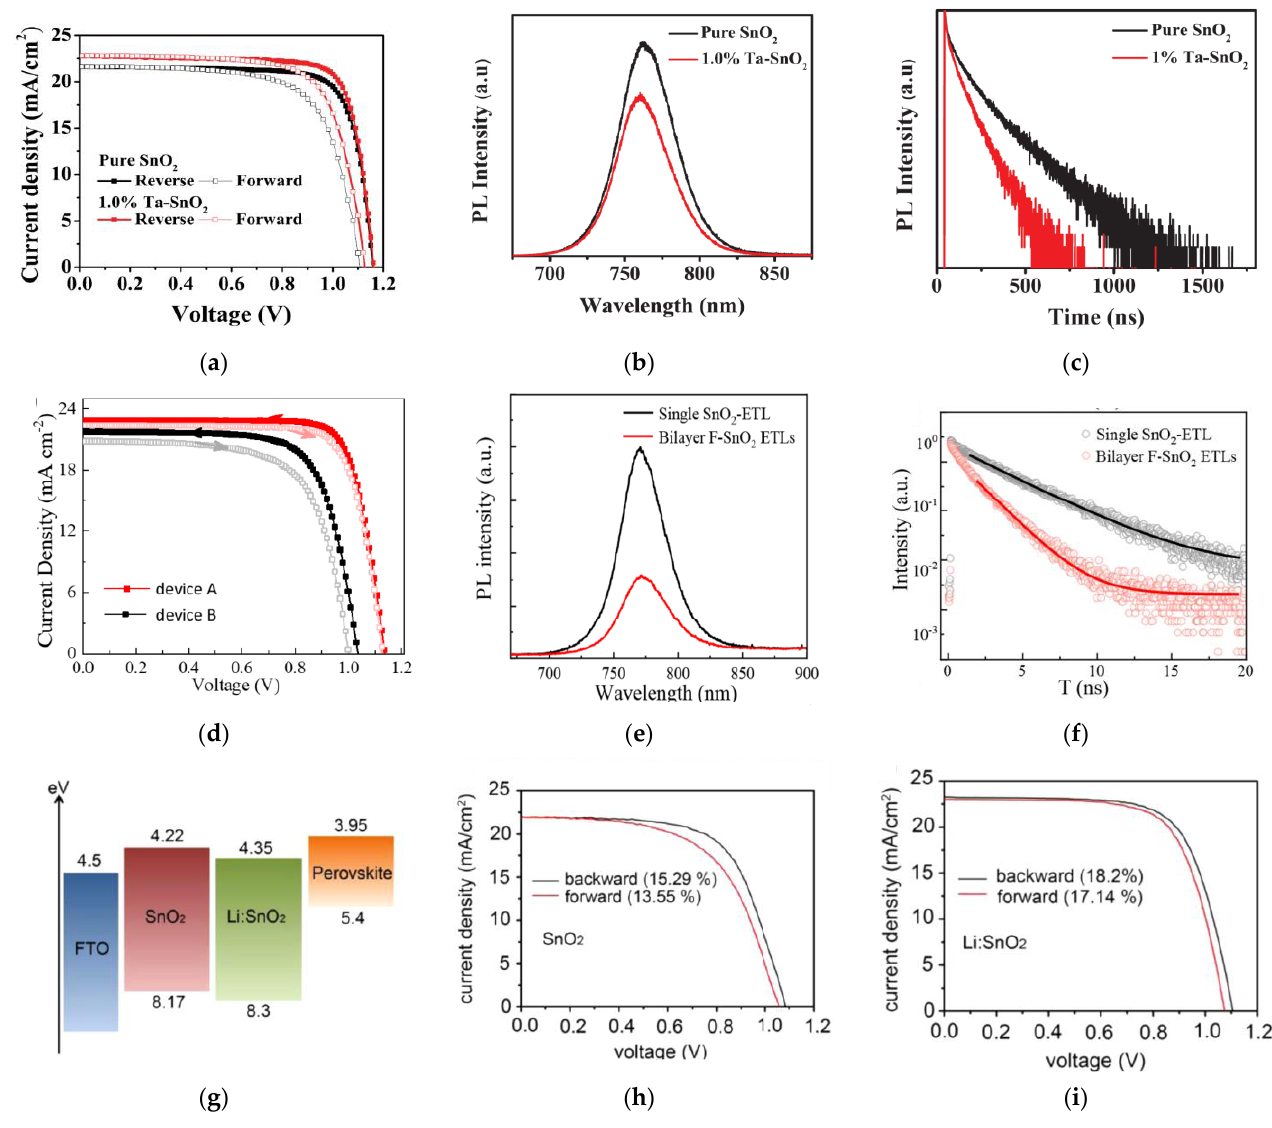
Figure 1. ( a ) Illuminated current density vs. voltage ( J - V ) curves under reverse and forward voltage scanning of PSC devices, ( b ) photoluminescence (PL) spectra, and ( c ) time-resolved PL (TRPL) spectra of perovskite films on undoped and Ta-doped SnO 2 ETLs. Reproduced from [22] with permission from AIP Publishing, 2019. ( d ) Illuminated J - V curves under 1 SUN under reverse and forward voltage scanning of PSC devices, ( e ) photoluminescence (PL) spectra, and ( f ) TRPL spectra of perovskite films on undoped and bilayer F-doped SnO 2 ETLs. Reproduced from [23] with permission from American Chemical Society (ACS) Publications, 2018. ( g ) Energy diagram of FTO, ETLs, and perovskite. Illuminated J - V curve of PSC based on ( h ) undoped SnO 2 and ( i ) Li-doped SnO 2 under 1 SUN. Reproduced from [24] with permission from Elsevier, 2016.